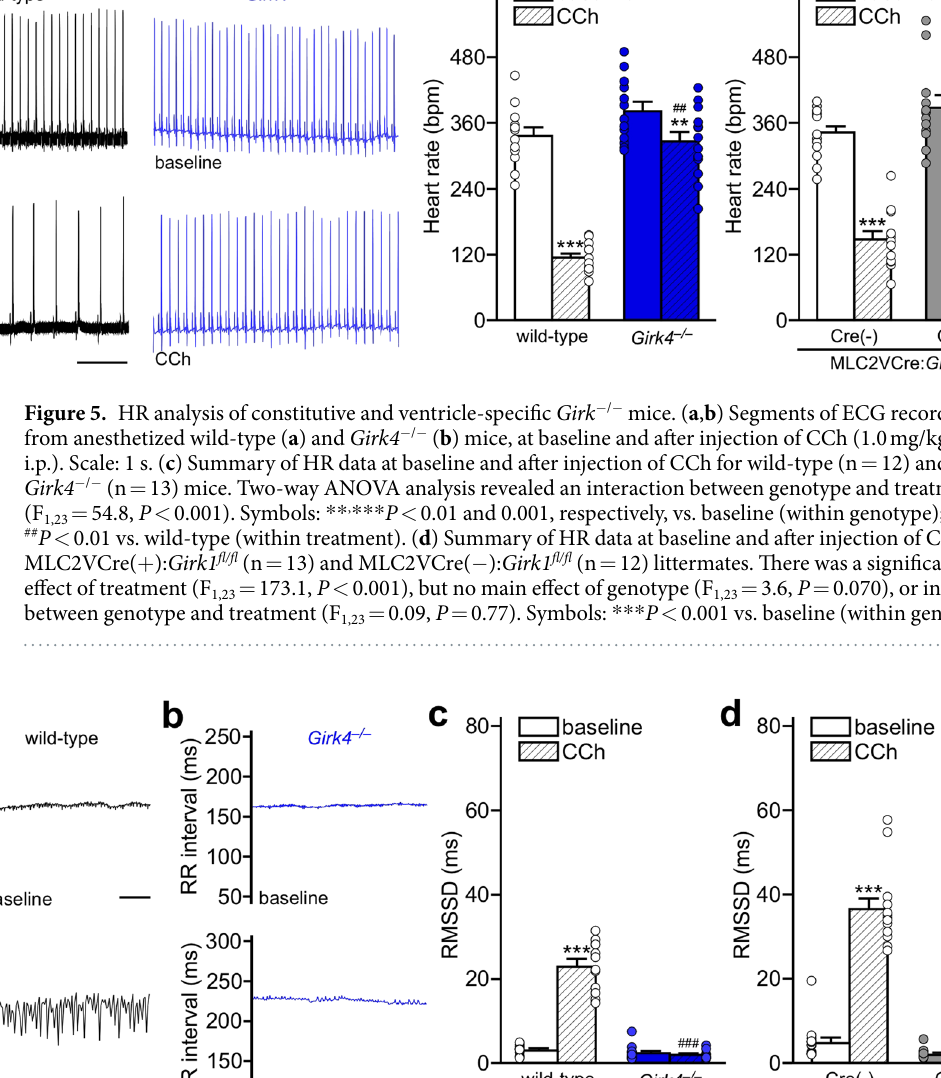
but this difference did not reach the level of statistical significance (Fig. 5a–c). Similarly, no significant differ- ence in baseline HR was observed in MLC2VCre( + ): Girk1 fl/fl mice relative to MLC2VCre( − ): Girk1 fl/fl con- trols (Fig. 5d). As expected, CCh decreased HR in wild-type mice, and this effect was significantly smaller in Girk4 − / − mice (Fig. 5a–c). In contrast, CCh-induced bradycardia was comparable in MLC2VCre( + ): Girk1 fl/fl and MLC2VCre( − ): Girk1 fl/fl mice (Fig. 5d). Arrhythmic events, defined as instances of AV block or tachycardic epi- sodes, were also quantified before and after CCh injection (Supplementary Fig. S2). While no arrhythmic events were observed at baseline for any genotype, wild-type mice exhibited more arrhythmic events than Girk4 − / − mice after CCh injection. Both MLC2VCre( + ): Girk1 fl/fl mice and MLC2VCre( − ): Girk1 fl/fl mice exhibited a similar frequency of arrhythmic events after CCh injection.